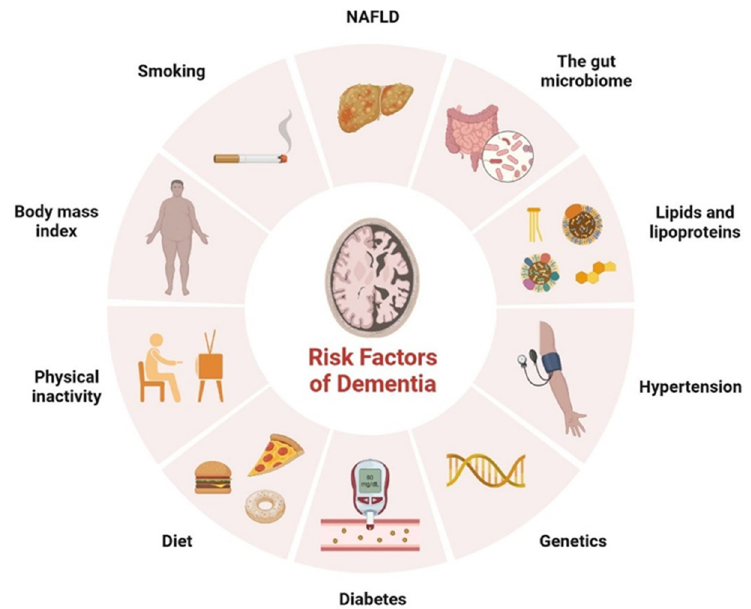
Figure 1. Representation of various risk factors involved in the development of dementia.